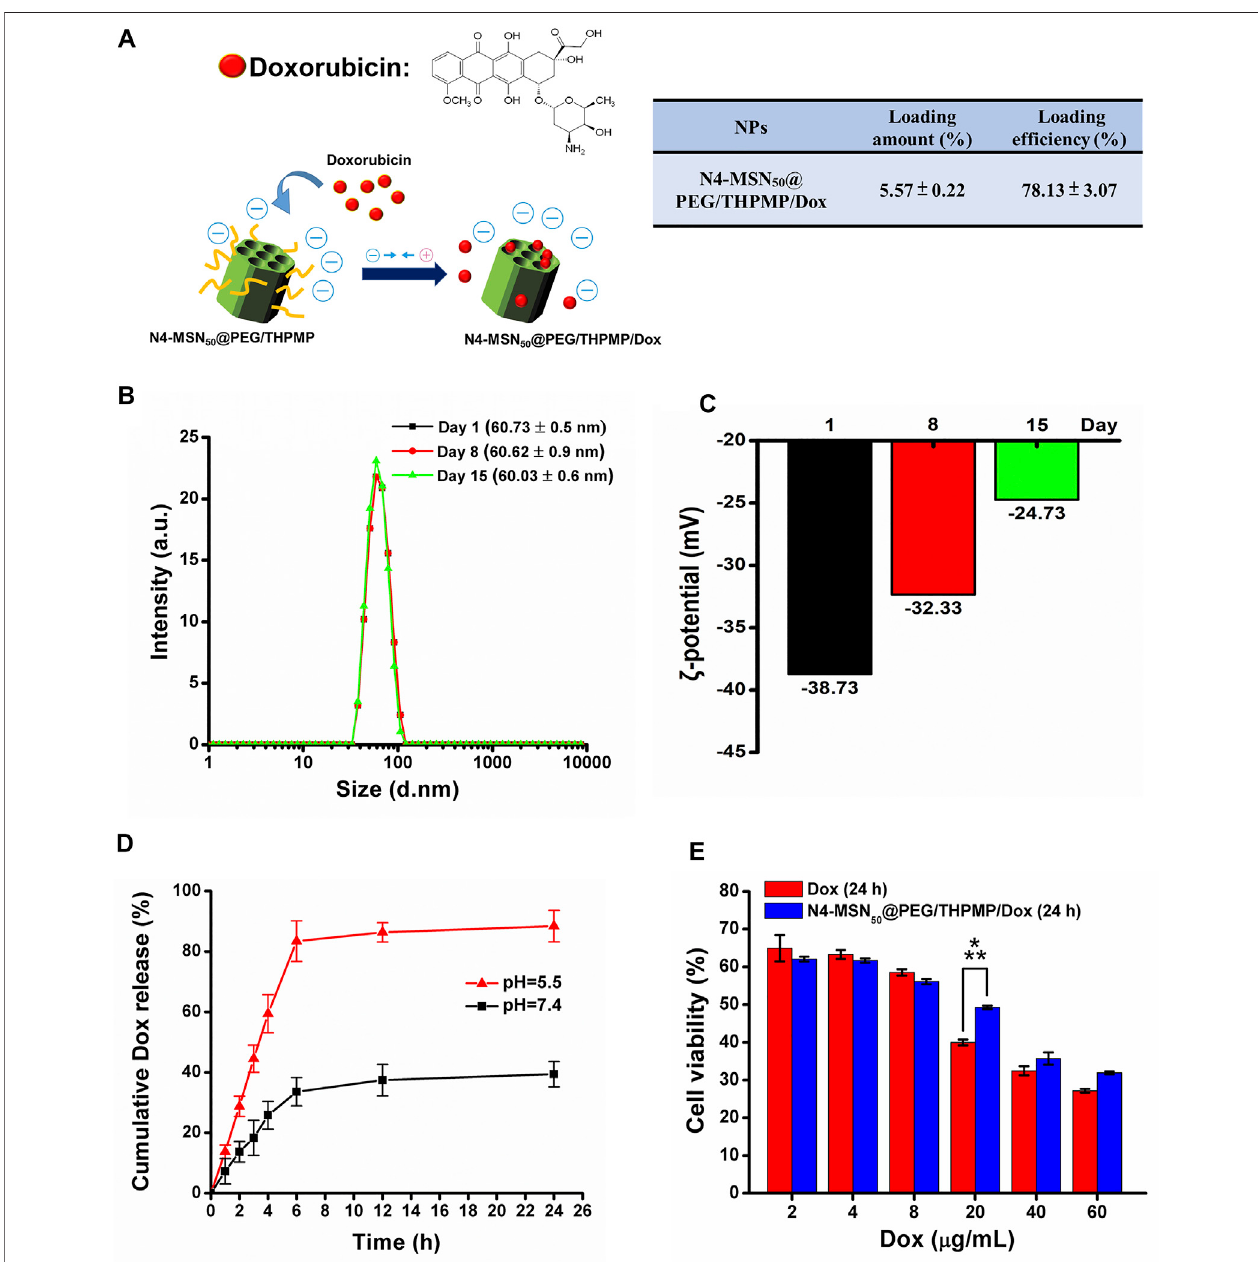
FIGURE 5 | N4-MSN 50 @PEG/THPMP-mediated doxorubicin (Dox) delivery against the U87-MG cells and their stability. (A) Schematic representation of Dox loading strategy and the loading capacity . Stability assay of N4-MSN 50 @PEG/THPMP/Dox by using (B) hydrodynamic diameter distributions and (C) zeta potential measurements inwaterat day1,8,and 15. (D) Invitro releasepro fi les ofDoxinPBSbuffer(pH 7.4and5.5) ataphysiological temperature (37 ° C). (E) Invitro cytotoxicity of U87-MG cells treated with different concentrations of free Dox or Dox-loaded N4-MSN 50 @PEG/THPMP (equivalent dose of Dox) for 24 h *** p < 0.001.